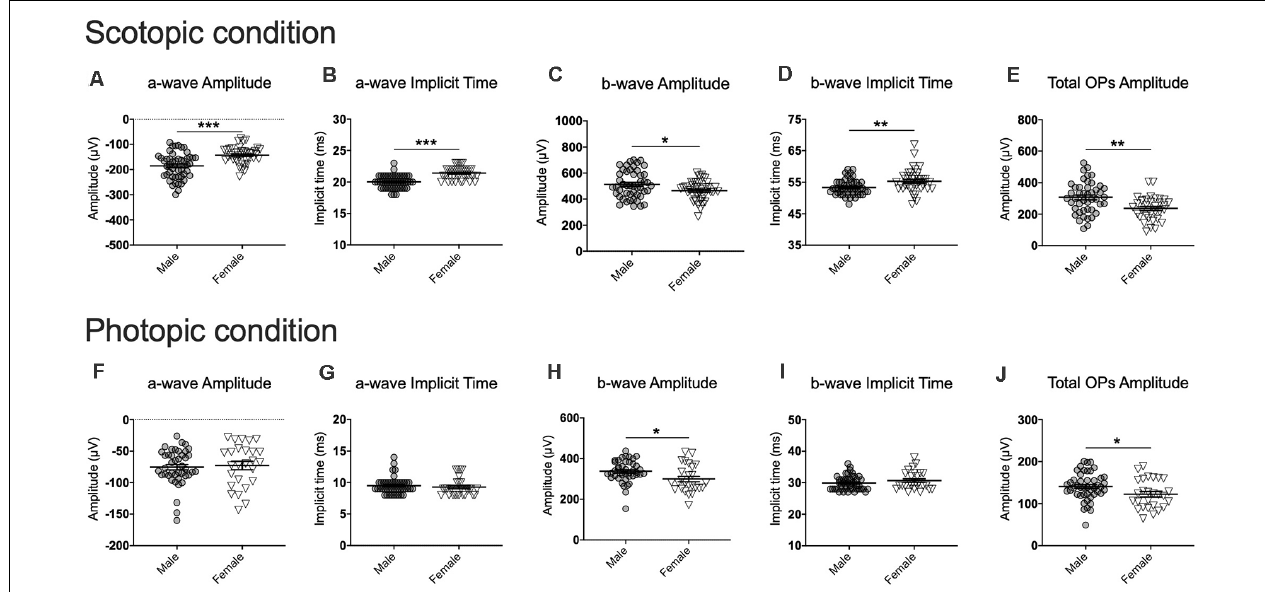
FIGURE 3 | Examples of comparison of males and females for each ERG component at baseline for the scotopic (1.89 log cd.s/m 2 ; A–E ) and photopic (2.86 log cd.s/m 2 ; F–J ) conditions. Note that all luminance steps were included in the analyses although they are not all presented here. (A–J) Overall, males exhibited stronger and faster signals than females at baseline. Significance was determined using linear mixed model analysis with LSD multiple comparisons test. Scatter plots depict each sample value of all groups of mice and bars represent the group average ± SEM; * p < 0.05, ** p < 0.01, *** p < 0.001; n -values are given in the “Materials and Methods”